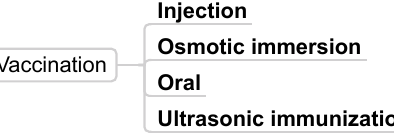
Figure 4. Partial taxonomy: Maintain stress-free environment.